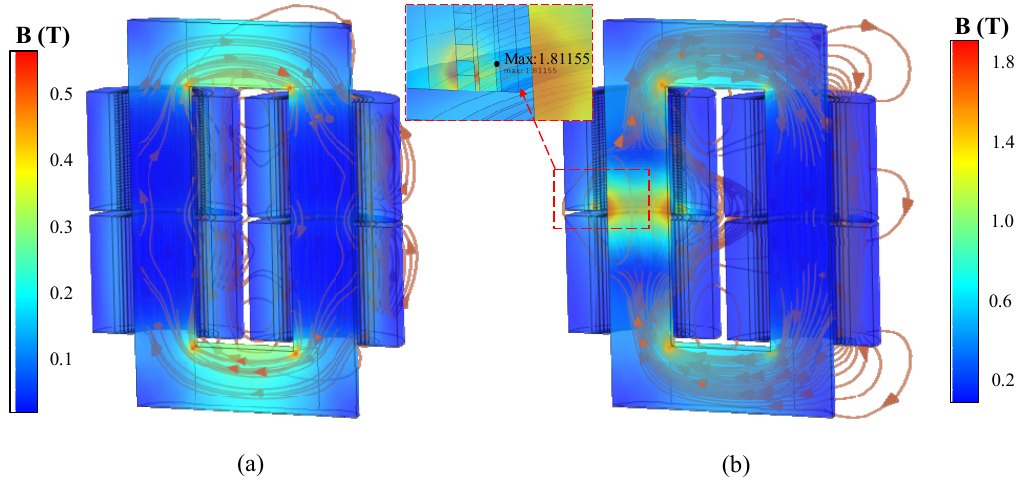
Figure 5. The normal magnetic field and the fault magnetic field of bottom TTF under the maximum of peak short-circuit current at 59 ms. ( a ) Normal magnetic field. ( b ) Fault magnetic field.